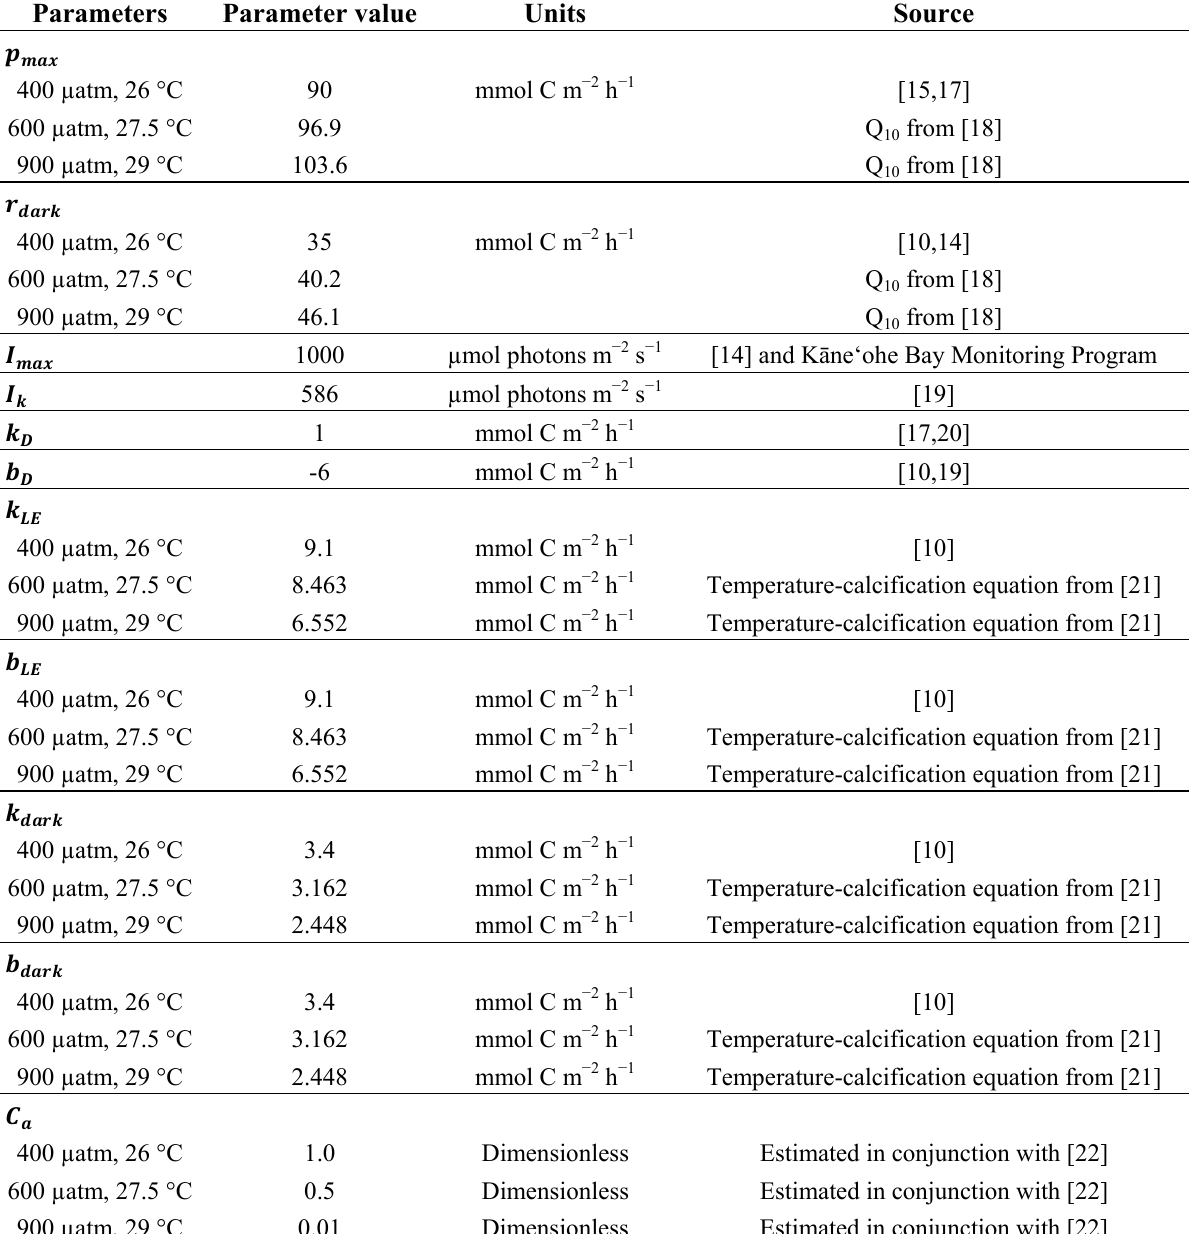
discussion of parameterization choices and